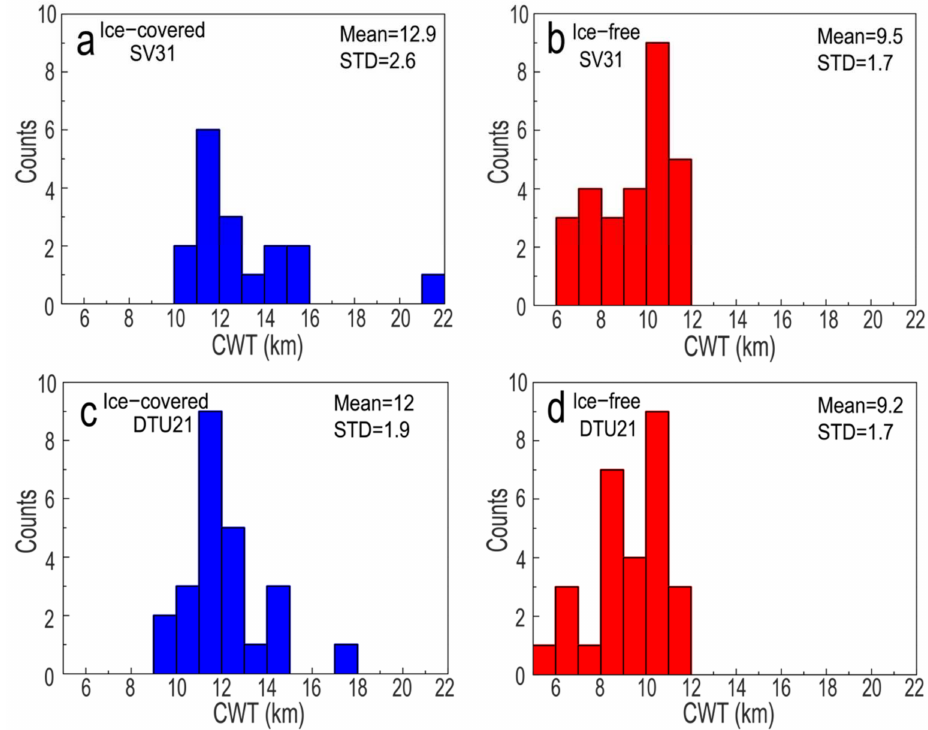
Figure 5. ( a – d ) Coherence transition wavelengths between shipborne and satellite altimetric gravity in different ice conditions. Blue and red columns indicate ice-covered and ice-free regions,